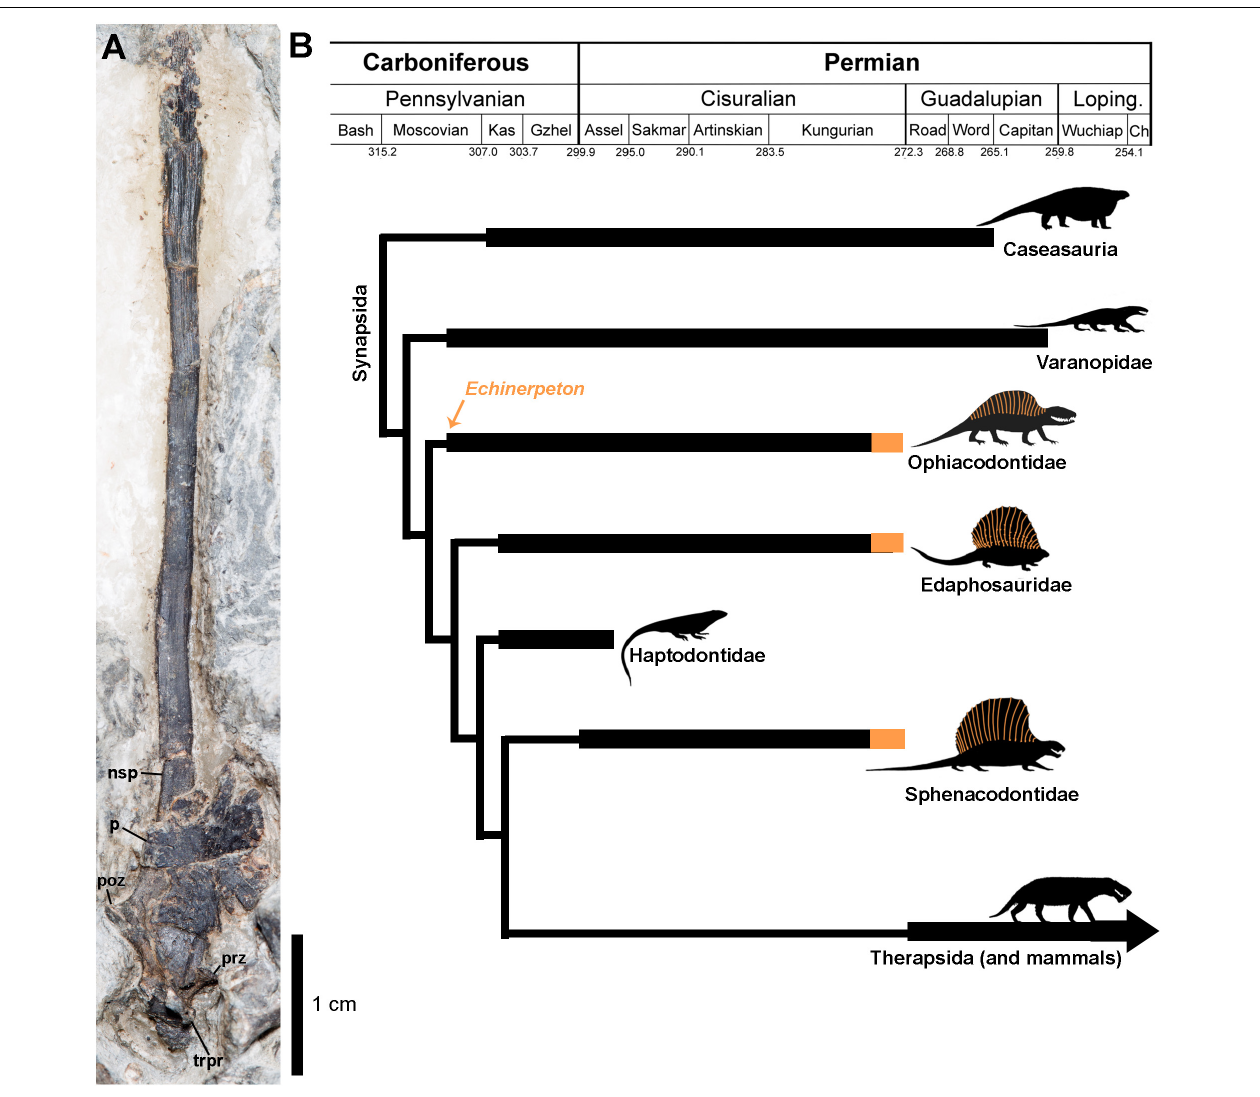
FIGURE 1 | (A) Hyper-elongated neural spine of Echinerpeton intermedium (B) Simplified time-calibrated cladogram (based on the relationships of Benson, 2012 and divergence dates of Maddin et al., 2020) showing the evolution of neural spine hyper-elongation in basal Synapsida indicated in orange. The orange arrow indicates the age of Echinerpeton intermedium . Anatomical abbreviations: nsp, neural spine; p, parietal; trpr, transverse process; poz, postzygapophysis; prz,